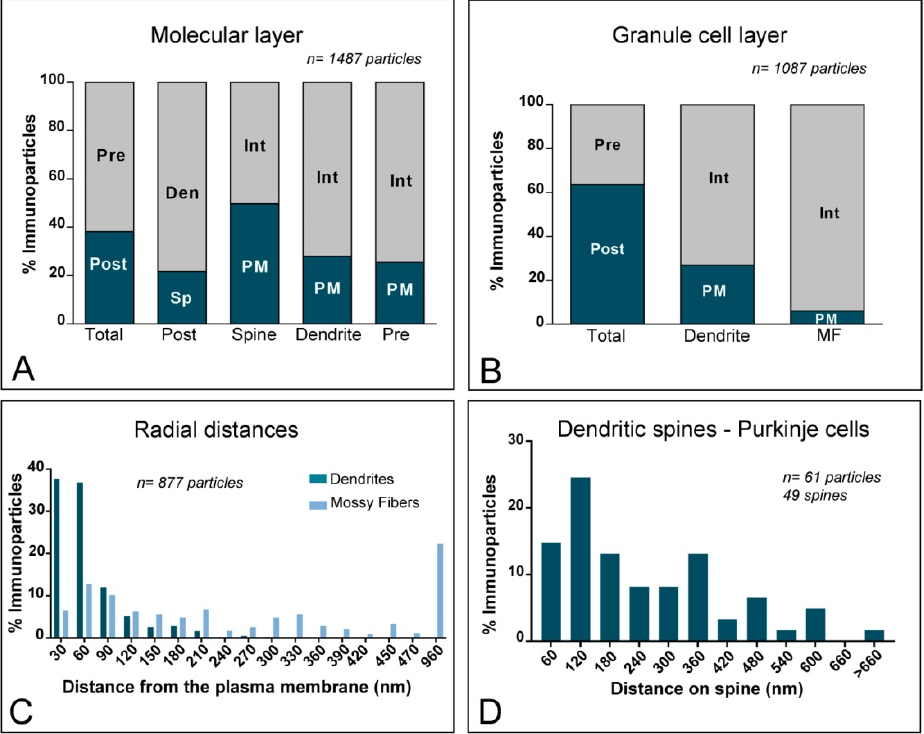
Figure 4. Compartmentalisation of Kv channel interacting protein (KChIP) subunit KChIP3 in cerebellar cells. ( A ) Bar graphs showing the percentage of immunoparticles for KChIP3 at post- and pre-synaptic compartments in the molecular layer. A total of 1487 immunoparticles in the molecular layer were analysed, of which 38.1% were postsynaptic and 61.9% were presynaptic. Postsynaptically, immunoparticles were detected in dendritic spines (21.7%) and in dendritic shafts (78.35%), distributed along the plasma membrane (49.6% in spines; 27.9% in dendrites) and at cytoplasmic sites (50.4% in spines; 72.1% in dendrites). Presynaptically, immunoparticles were detected in parallel fibres of ML (61.9%) distributed along the plasma membrane (25.5%) and at cytoplasmatic sites (74.5%). ( B ) Bar graphs showing the percentage of KChIP3 immunoparticles at post- and pre-synaptic compartments, and along the plasma membrane and intracellular sites in dendritic shafts of granule cells and mossy fibres in the granule cell layer. A total of 1087 immunoparticles in the granular cell layer were analysed, of which 63.5% were postsynaptic and 36.5% were presynaptic. Postsynaptically, immunoparticles were detected in dendrites of GCs (63.5%), distributed along the plasma membrane (27%) and at cytoplasmic sites (73%). Presynaptically, immunoparticles were detected in mossy fibre terminals (36.5%), distributed mostly at cytoplasmic sites (94%) and very few along the plasma membrane (6%). ( C ) Histogram showing the radial distribution of KChIP3 immunoparticles from the plasma membrane towards cytoplasmic sites in dendrites of GCs and mossy fibres. In dendrites, immunoparticles for KChIP3 showed a skewed frequency distribution in the plasma membrane direction, but in mossy fibres they were more equally distributed across the axoplasm. ( D ) Histogram showing the distribution of immunoreactive KChIP3 in relation to glutamate release sites in dendritic spines PCs. The data show the proportion of KChIP3 immunoparticles at a given distance from the edge of the postsynaptic density. About 68.9% of immunolabelled KChIP3 are located in a 60–300 nm wide band, and then the density decreased markedly further in the spine membrane. In the granule cell layer, 1087 immunogold particles were analysed and, of those, 690 (63.5%) were distributed at postsynaptic sites and 397 (36.5%) at presynaptic sites (Figure 4B). At postsynaptic sites, 63.5% of KChIP3 immunoparticles were distributed in dendrites of GCs (27% were located on the plasma membrane and 73% at intracellular sites) (Figure 4B). At presynaptic sites, KChIP3